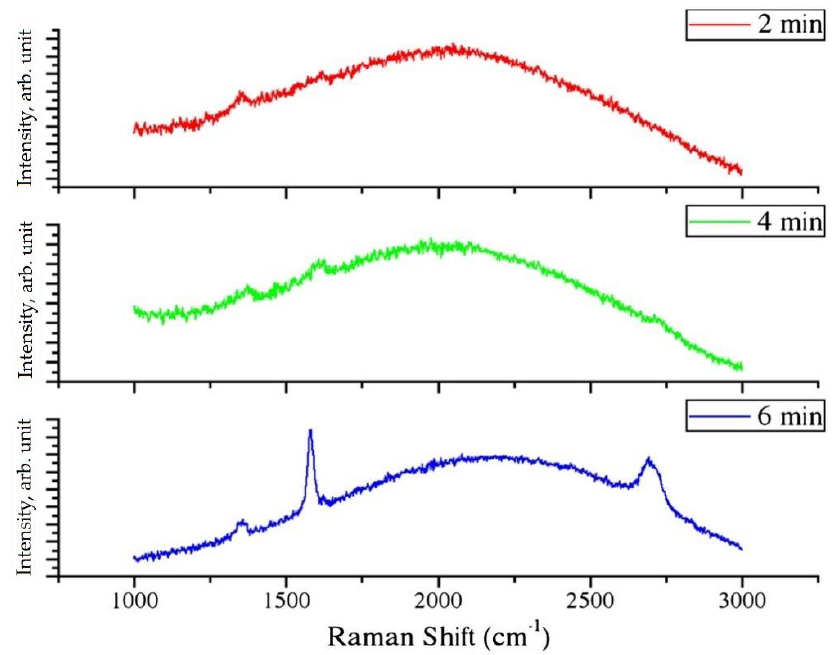
Figure 29. Raman spectra of graphene grown on electroformed Cu foils: exposure time of 2, 4, and 6 min [47].